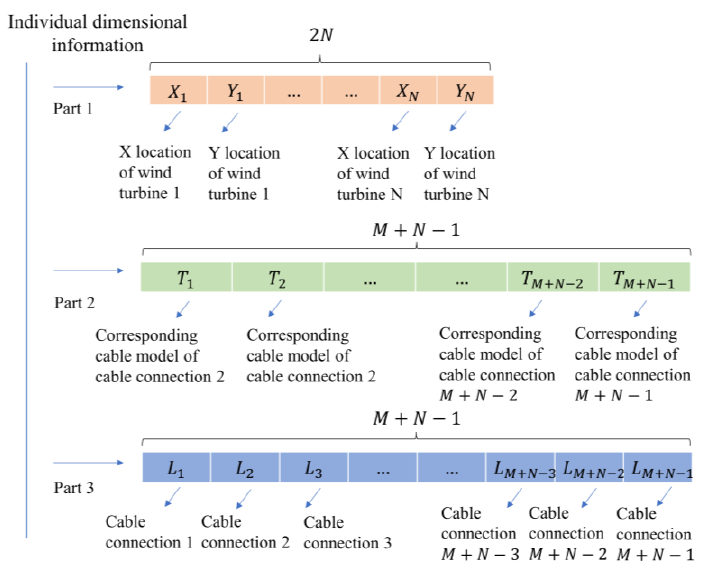
Figure 1. Schematic diagram of optimized variable coding.